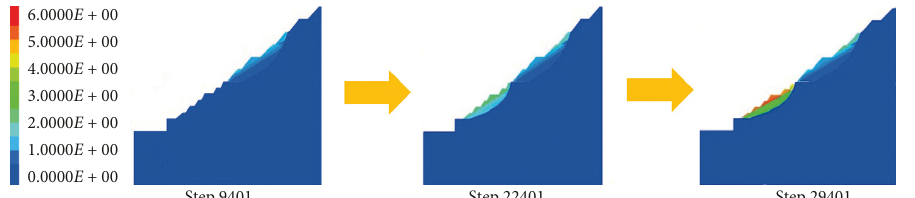
Figure 28: Key point displacement slice contour.